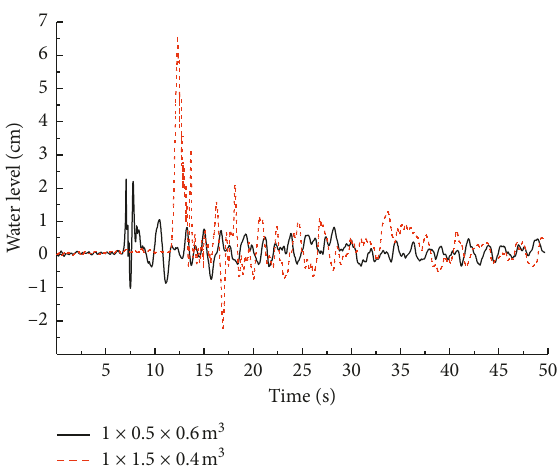
Figure 13: Height of the first wave caused by landslides with different square volumes. The labels are length, width, and thickness in sequence, such as the length is 1m, the width is 0.5m, the thickness is